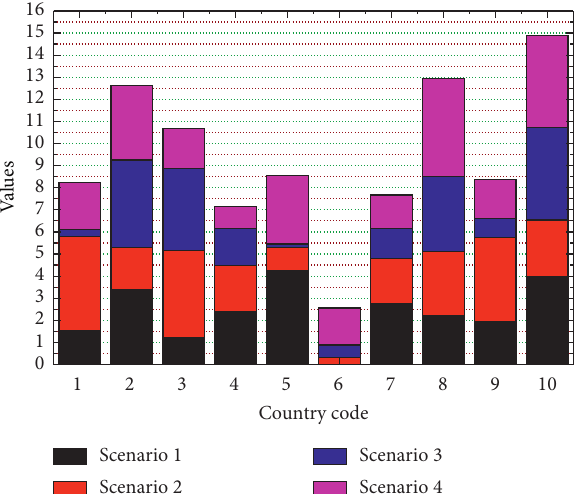
Figure 8: Changes in terms of trade by region under two shock scenarios.